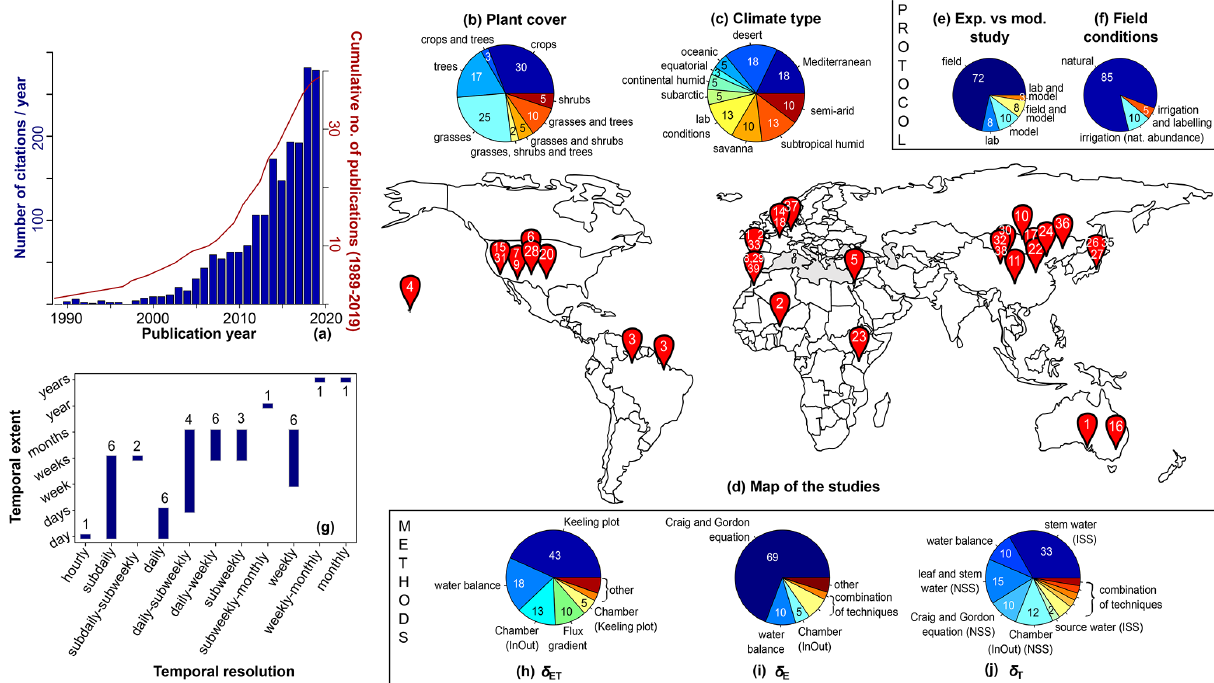
Figure 2. Graphical summary of the reviewed literature. (a) Evolution of the number of citations per year (blue bars) and cumulative number of publications (1989–2020, red line). (b) Temporal resolution vs. extent of the estimate of the transpiration-to-evapotranspiration ratio ( T/ET ). Numbers above or below the histograms refer to the number of studies working at a given temporal resolution. (c, d) Listing of the different plant cover and climate types with proportions (white label) expressed in percentage and (g) map locating each study (with reference number 1–39 with a white label; see Table A1). (e, f) Proportions of field vs. modelling studies and prevailing experimental conditions (as natural precipitation or irrigation or else as labelling studies). (h–j) Listing and proportions of methods for determination of δ ET , δ E , and δ E